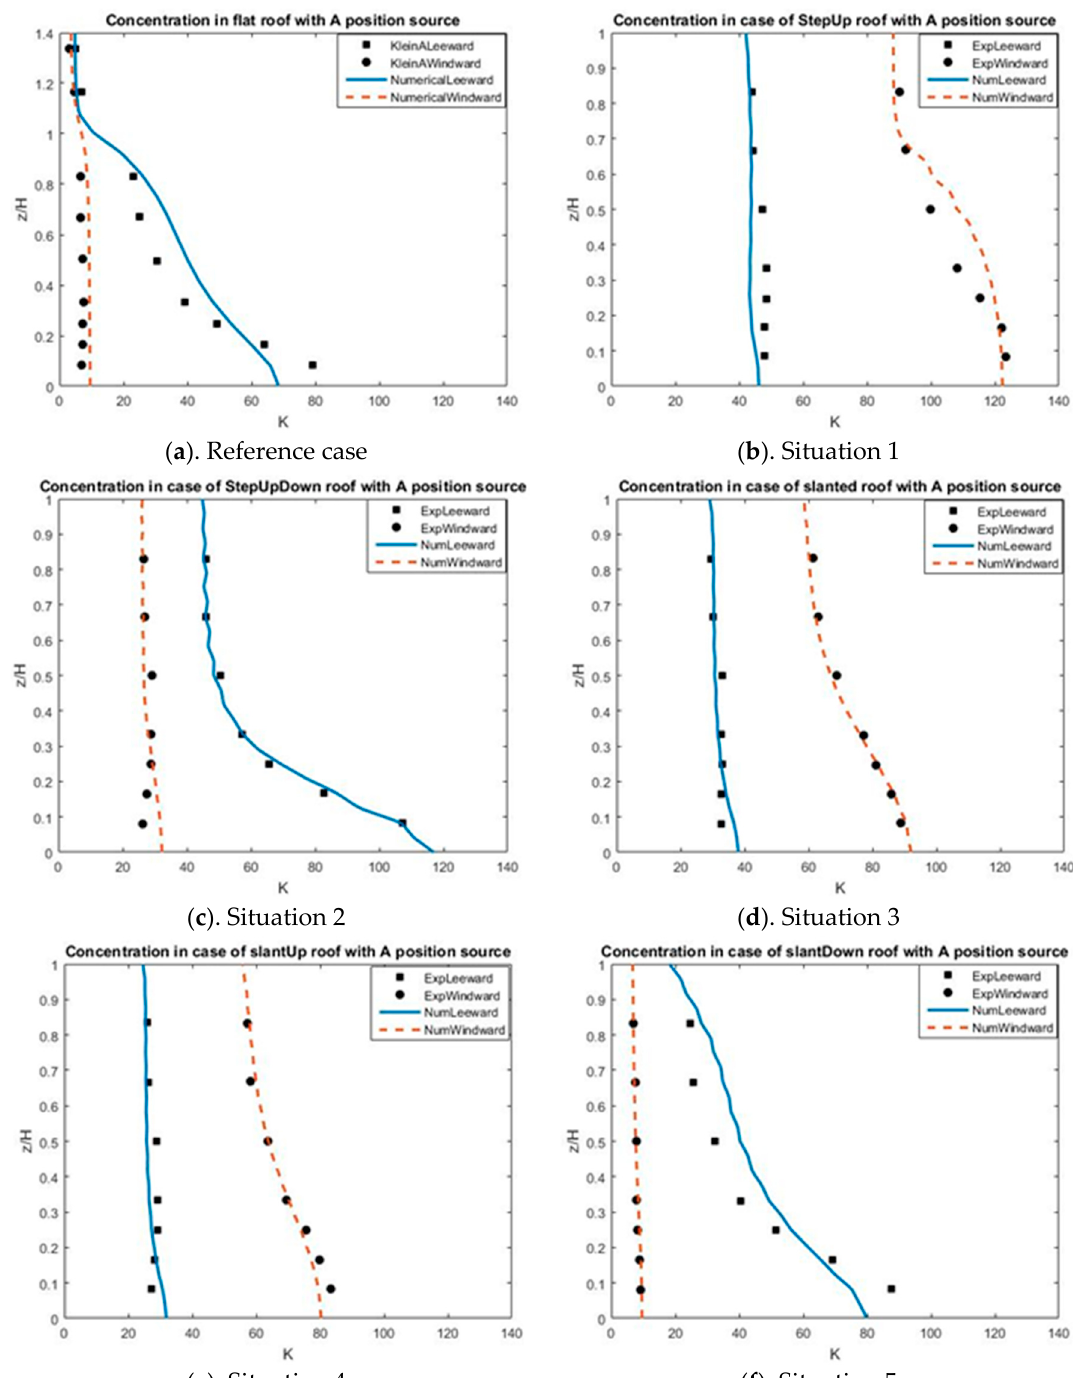
Figure 24. The dimensionless concentration K along the leeward and windward sites in the reference case (flat roof) corresponding to position sources located at A ( left ) and B ( right ).